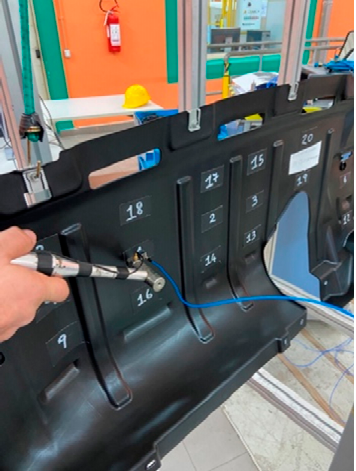
Figure 4. Instrumented hammer and shelter component.